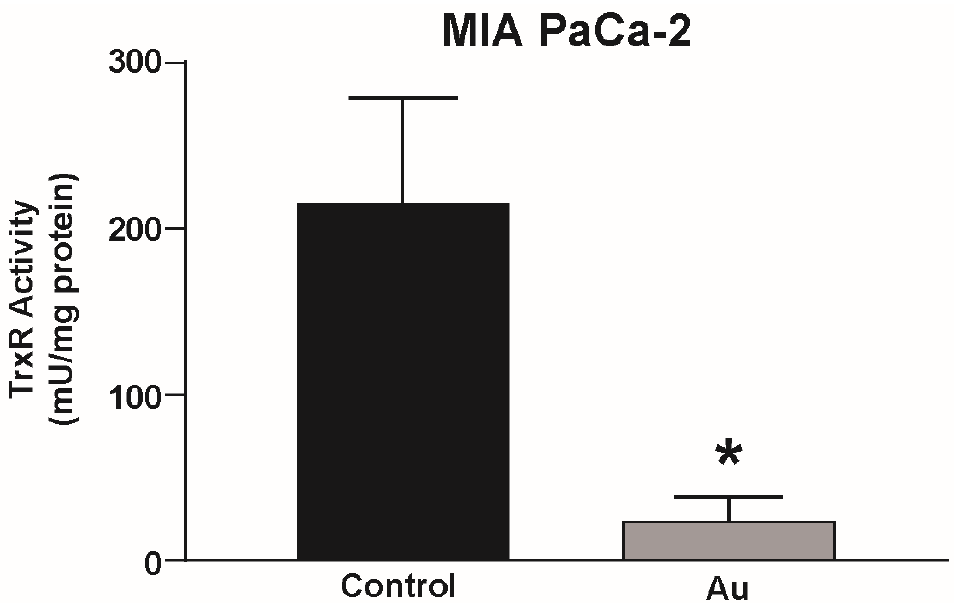
Figure 3. Au inhibits thioredoxin reductase activity in pancreatic cancer cells. MIA PaCa-2 cells were incubated with 1 µM Au for 3 h prior to measuring thioredoxin reductase activity. Au significantly reduced thioredoxin reductase activity compared to control. Data represent thioredoxin reductase activity in mU/mg protein ± SE (* p < 0.05; two-tailed unpaired Student’s t test). Reprinted/adapted with permission from [102,103]. Copyright 2017, O’Leary, Elsevier.